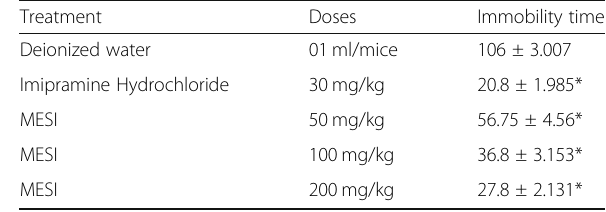
Table 1 Effect of MESI in TST Table 2 Effect of MESI in